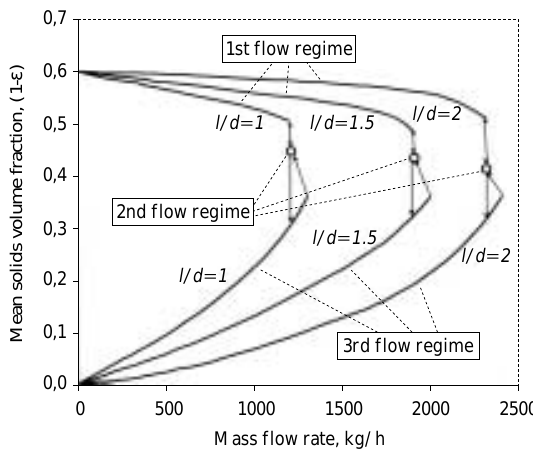
General status diagram of flow regimes in gravity mixer tubes containing motionless mixers